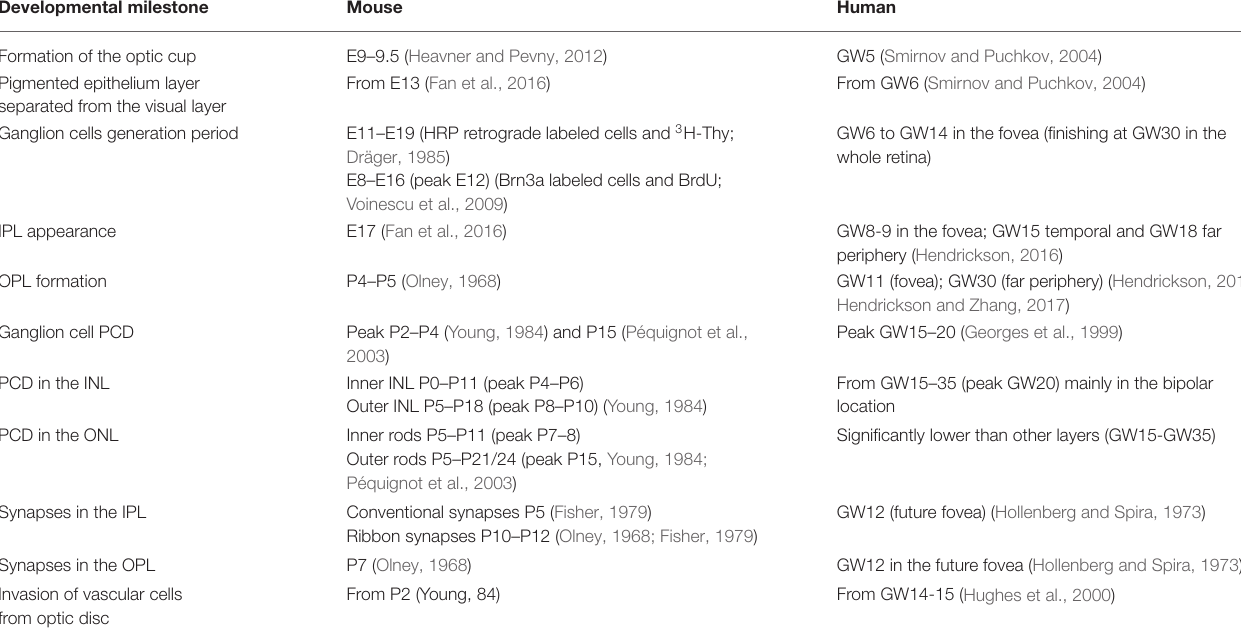
TABLE 1 | Comparison of the temporal course of retinal development in mice and in humans. Developmental milestone Mouse Human Formation of the optic